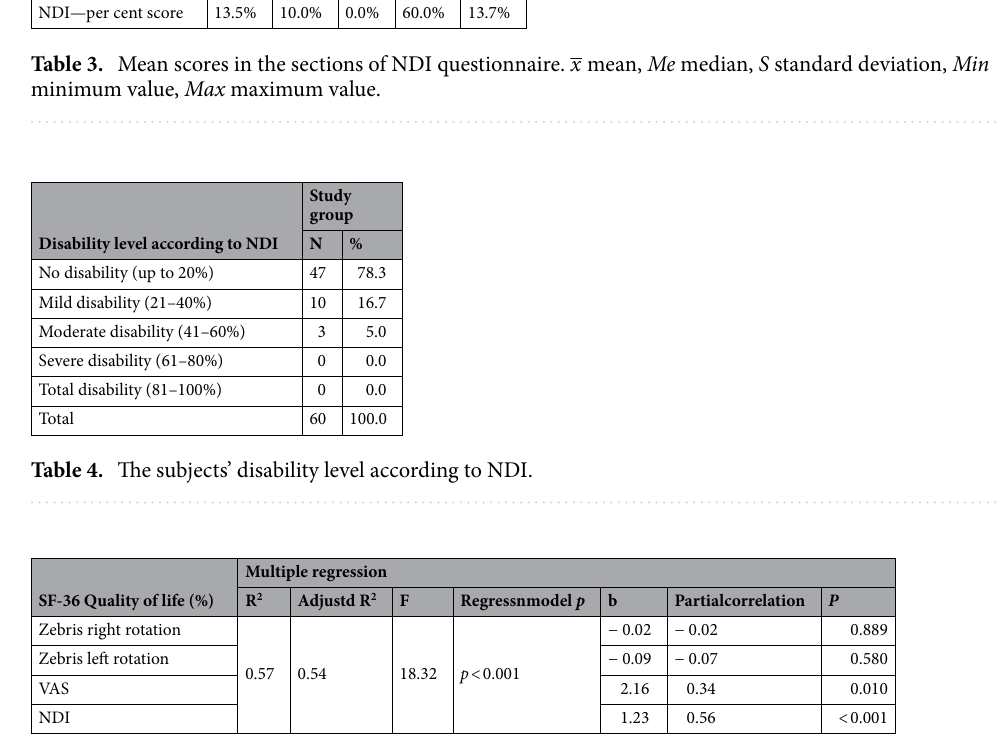
Table 5. Assessment of overall quality of life depending on range of rotation, pain intensity and disability level (Zebris / VAS / NDI). R 2 , regression model; Adjusted R 2 , regression model, removes extreme values; F, Fisher’s test result; b, regression coefficient; partial correlation, the variable Xi is correlated with the variable Y after accounting for effects of all the remaining independent variables (simultaneous effect of all the four factors); p significance